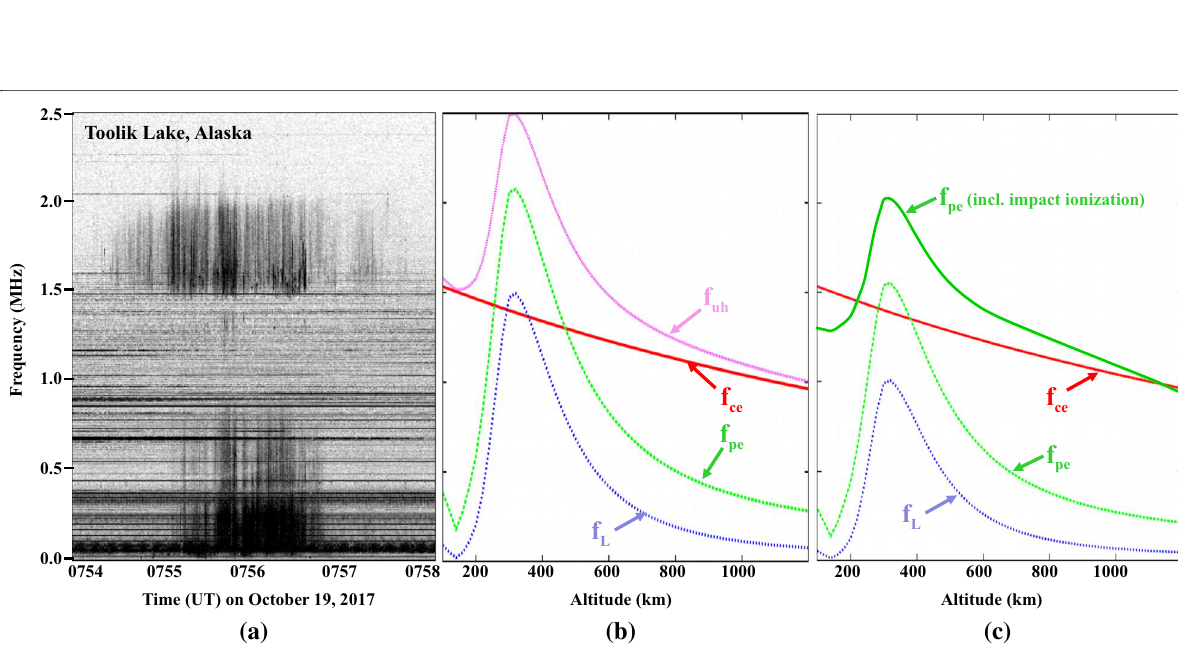
Fig. 4 a Spectrogram of intensity of MFB emissions observed at Toolik Lake on October 19, 2017; b altitude profiles of key frequencies ( f ce , f pe , f f L ) above Toolik Lake for the date and time of the observations in a , based on IGRF and IRI model values of magnetic field and electron uh , and density; c altitude profiles of key frequencies calculated by scaling the IRI profile such that the maximum L-cutoff frequency lies below all observed left-polarized MFB, and plasma frequency profile (solid green trace) obtained by adding to the scaled-IRI model an enhancement approximating that expected from impact ionization due to low-energy auroral